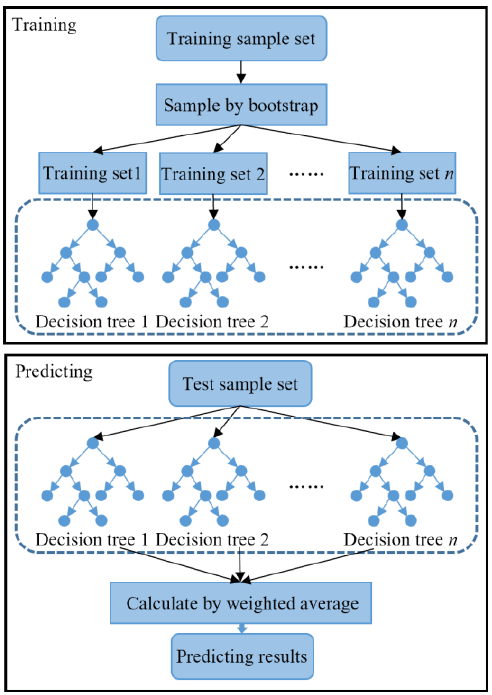
Figure 3. Schematic diagram of random forest algorithm.